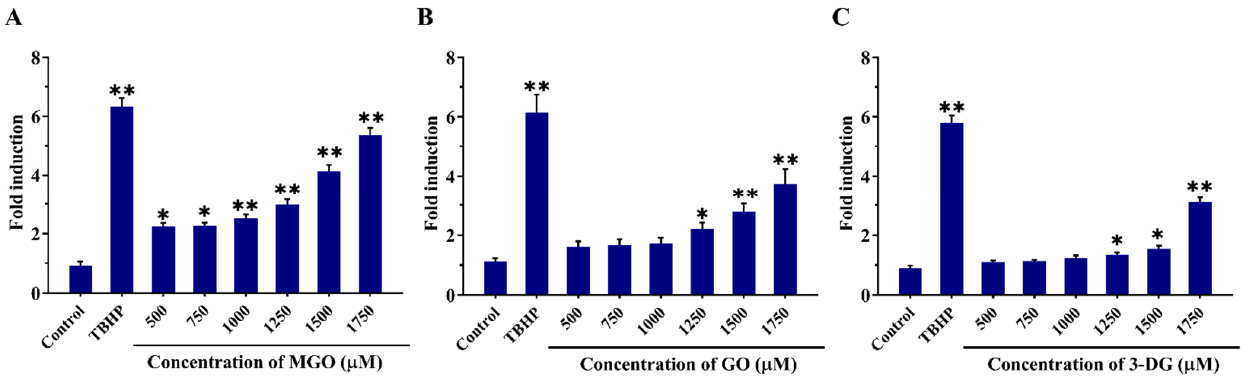
Figure 7. Effects of MGO ( A ), GO ( B ) and 3 ‐ DG ( C ) on the reactive oxygen species (ROS) produc ‐ tion in Nrf2 CALUX cells. tert ‐ Butyl hydroperoxide (TBHP) at 50 μ M was used as the positive con ‐ trol. Data are presented as mean ± SEM of three independent replicates. * p < 0.05 and ** p < 0.01 compared with the solvent control.